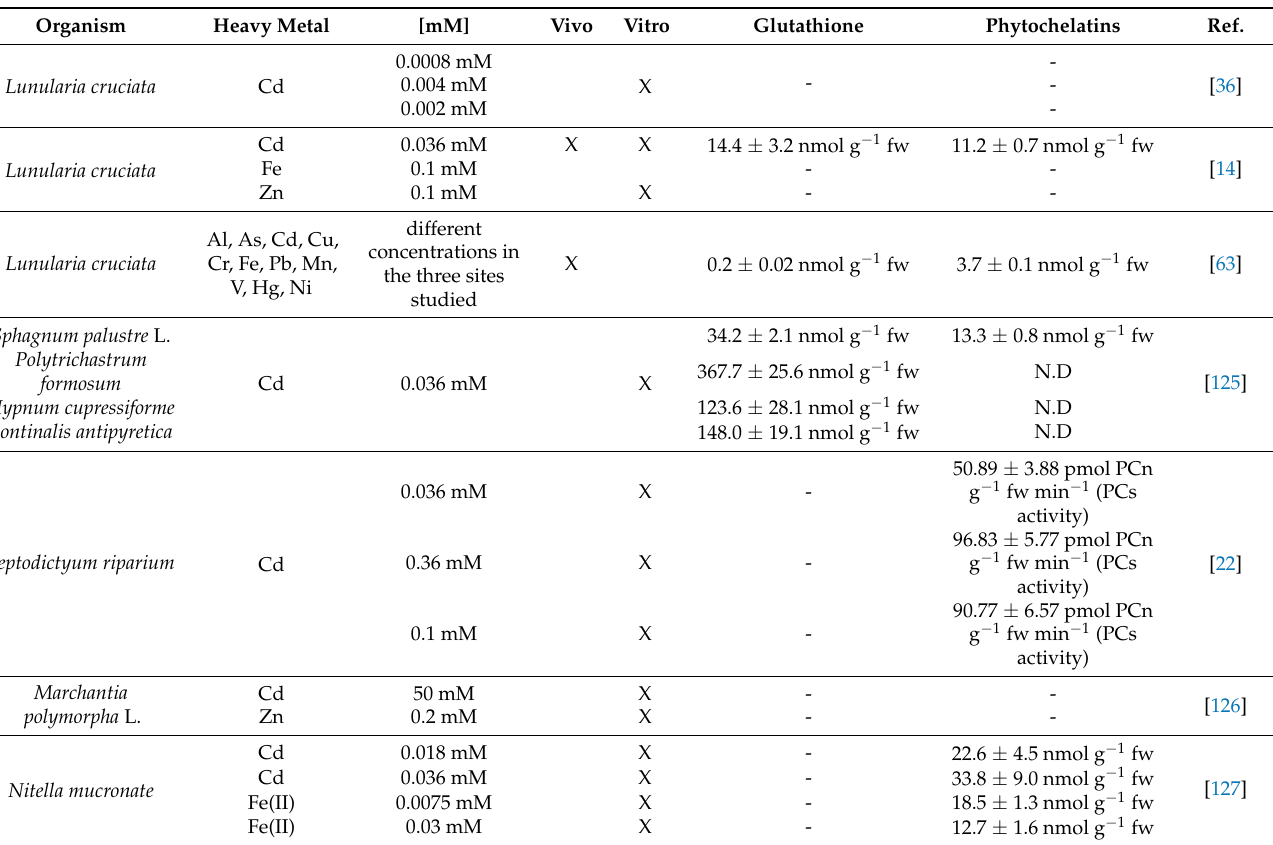
Table 1. Significant studies on the role of glutathione and phytochelatins in heavy-metal-stress tolerance in